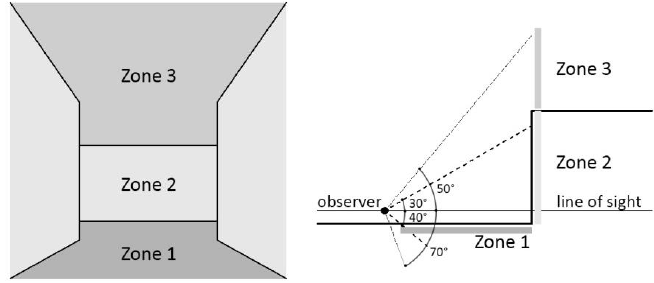
Figure 1. Zones 1, 2, and 3 in an urban visual scene, front view and section